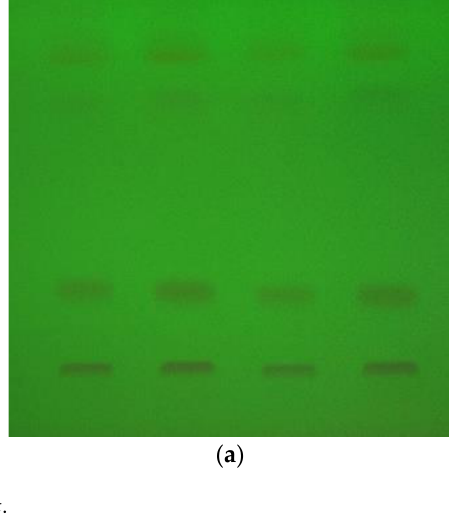
Figure 2. An example of chromatograms (image) for vitamin B12 with different concentrations (in the linearity range) registered in ( a ) daylight and ( b ) under a UV lamp (254